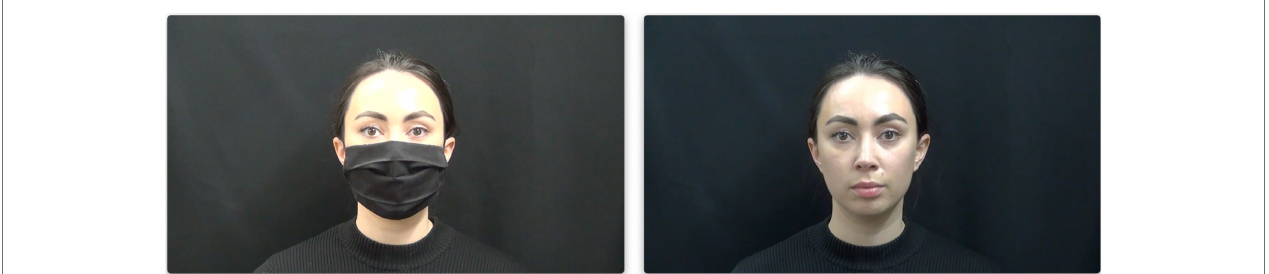
FIGURE 1 | The speaker with and without a face mask in neutral